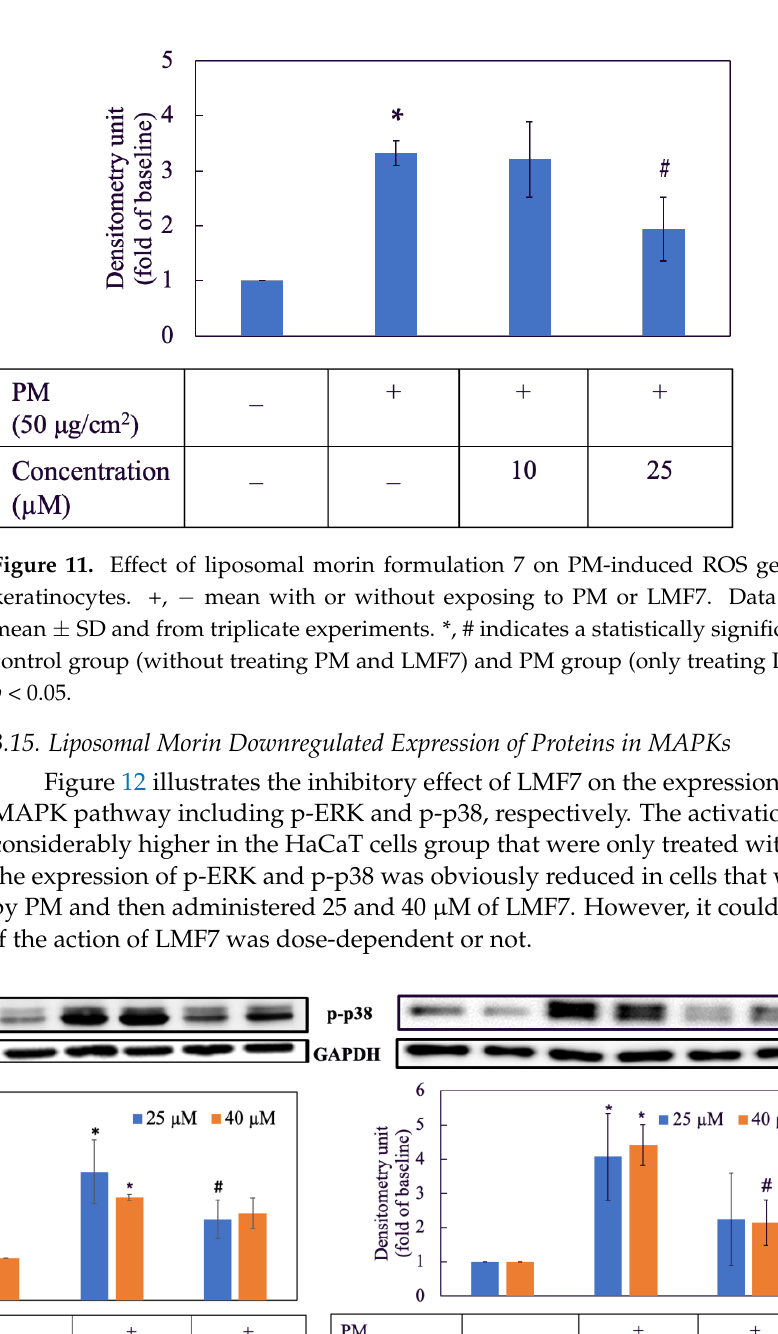
Figure 13. MMP-1 protein expression. Cells were pre-incubated with blank liposome or liposomal morin formulation 7 for 3 h and then treated with PM for 6 h. +, − mean with or without exposing to PM or LMF7, respectively. Data were presented as mean ± SD and from triplicate experiments. *, # indicates a statistically significant difference with control group (without treating PM and LMF7) and PM group (only treating LMF7), respectively, p < 0.05.